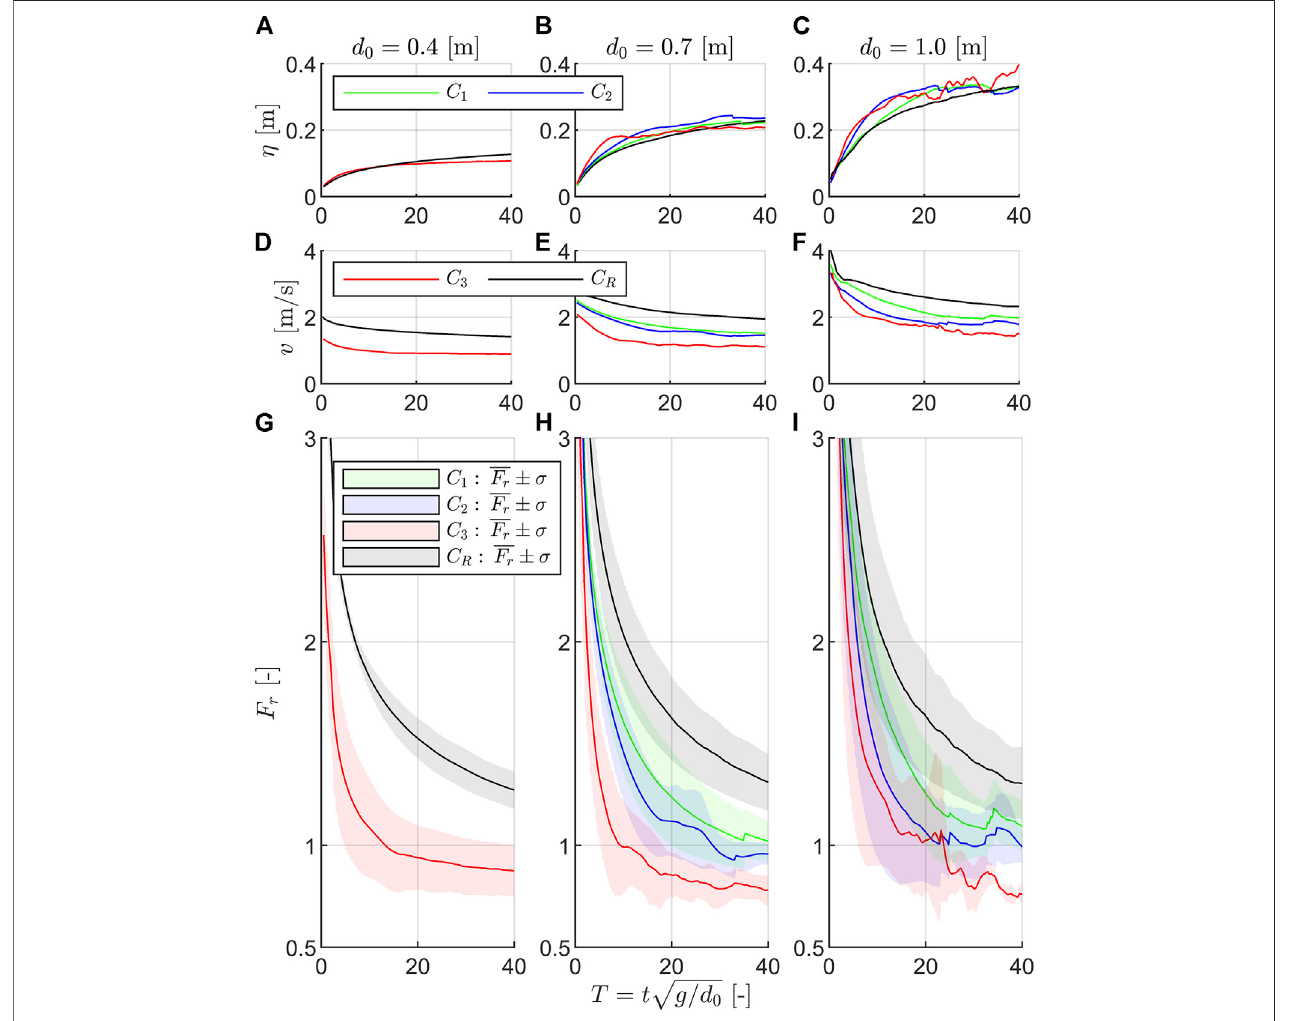
FIGURE 12 | Visualization of class-averaged surface elevation ( η , (A – C) ), depth- and class-averaged velocity ( v , (D – F) ), and class-averaged Froude number ( Fr , (F – I) ) at the transition point over dimensionless time and separated by initial impoundment depth ( d 0 ). Standard deviation (2 σ ) is displayed as a shaded area.